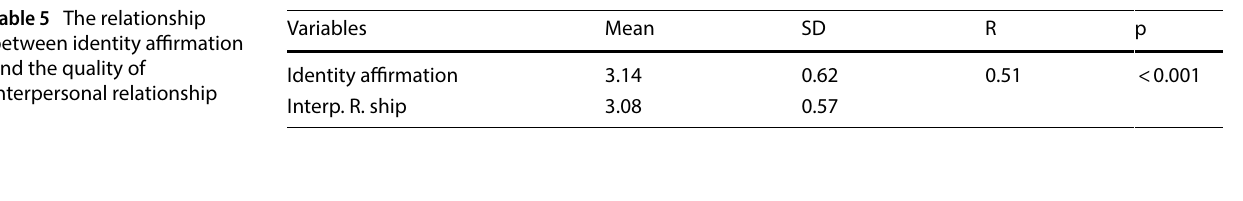
Table 6 T-test analysis showing the difference scores of remotely acculturating and non acculturating participants on identity